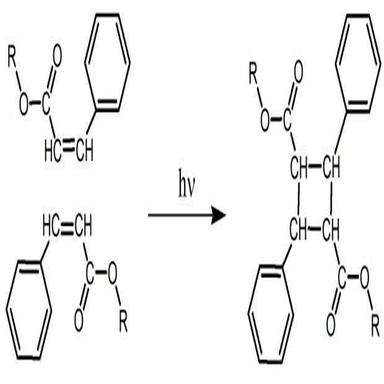
Cis-trans isomerization and photo-crosslinking processes of the cinnamic acid moiety.